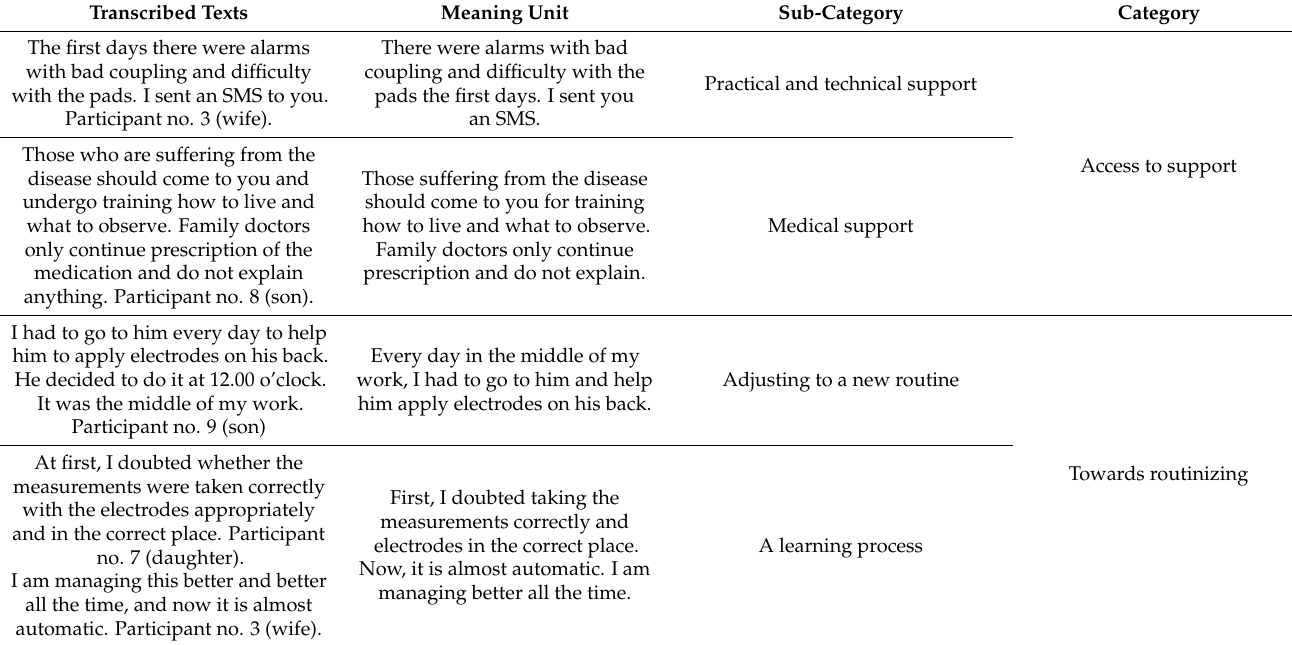
Table 1. Example of analysis from transcribed text, meaning unit, sub-category, and